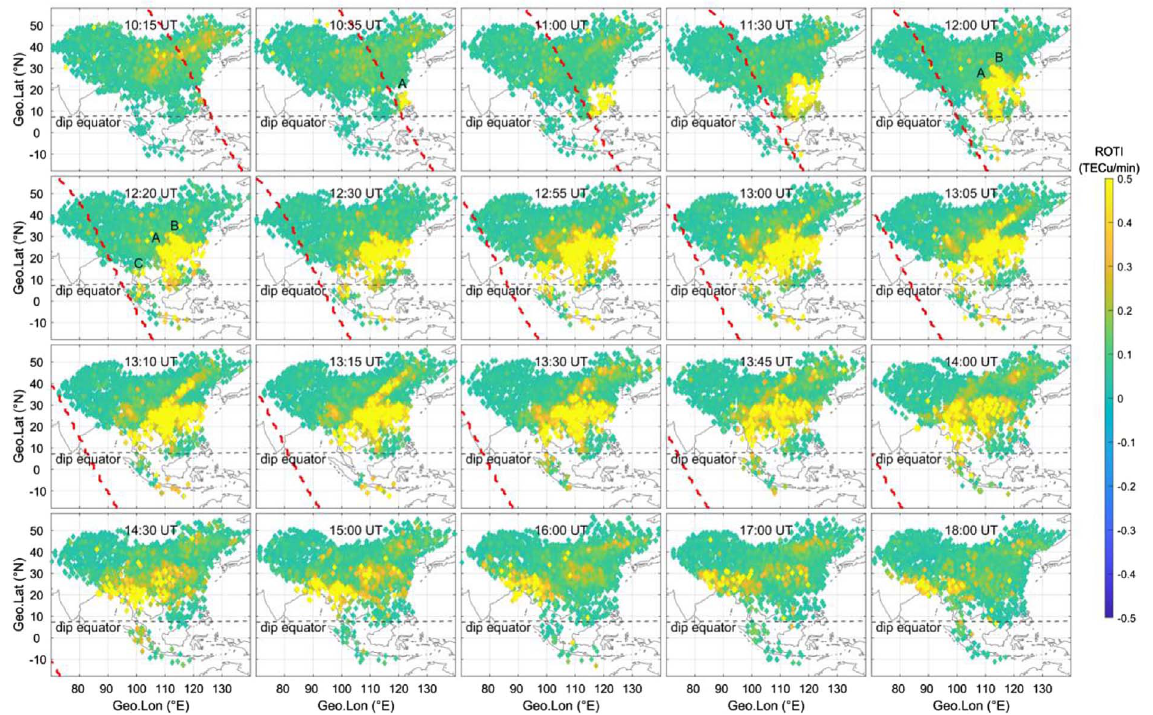
Fig. 2. A sequence of ROTI maps from 10:15 to 18:00 UT on 15 January 2022 observed by GNSS networks showing the evolution of the EPBs. The black and red dashed curves in each panel denote the magnetic dip equator and the sunset terminator at E-region altitude (100 km), respectively.